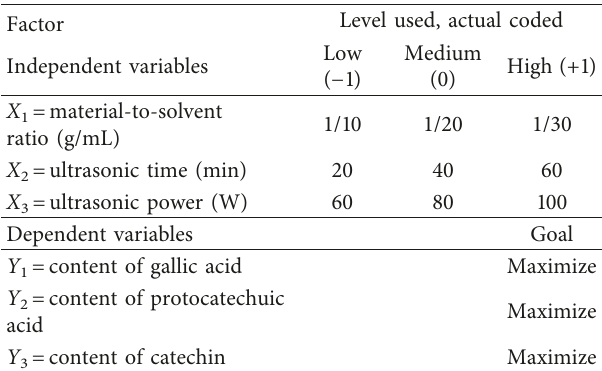
Table 1: The sample list of C. songaricum . Table 2: Independent and dependent variables used in the Box- Behnken design for the optimization of C. songaricum